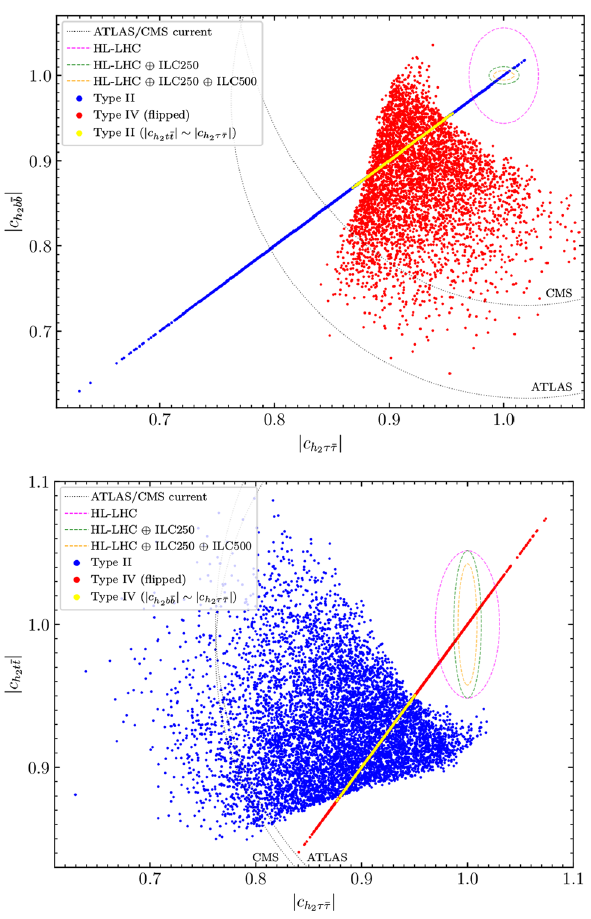
Fig. 11 Scan points of our analysis in the type II (blue) and type IV | - | c | plane (top) and the | c | - | c | (red) scenario in the | c h h 2 τ ¯ τ h 2 t ¯ t h 2 b ¯ b 2 τ ¯ τ plane (bottom). In the upper plot we highlight in yellow the points of the type II scenario that overlap with points from the type IV scenario in the lower plot, i.e., points with | c h ¯ t | ∼ | c h ¯ b | ∼ | c h 2 τ ¯ τ | . In the 2 t 2 b same way in the lower plot we highlight in yellow the points of the type IV scenario that overlap with points from the type II scenario in the upper plot. The dashed ellipses are the projected uncertainties at the HL-LHC [110] (magenta) and the ILC [109] (green and orange) of the measurements of the coupling modifiers at the 68% confidence level, assuming that no deviation from the SM prediction will be found (more details in the text). We also show with the dotted black lines the 1 σ ellipses of the current measurements from CMS [98] and ATLAS [97]